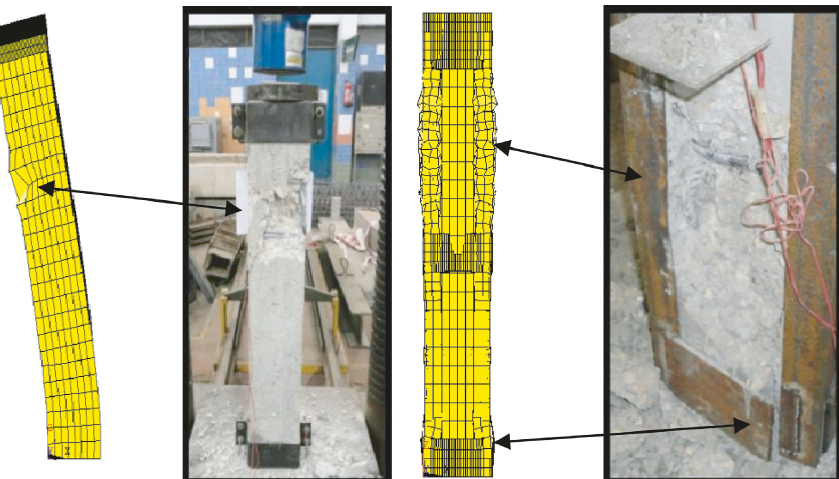
Figure 5: Deformations, failure modes, and locations obtained from both experimental Belal et al. [3] and FE results.